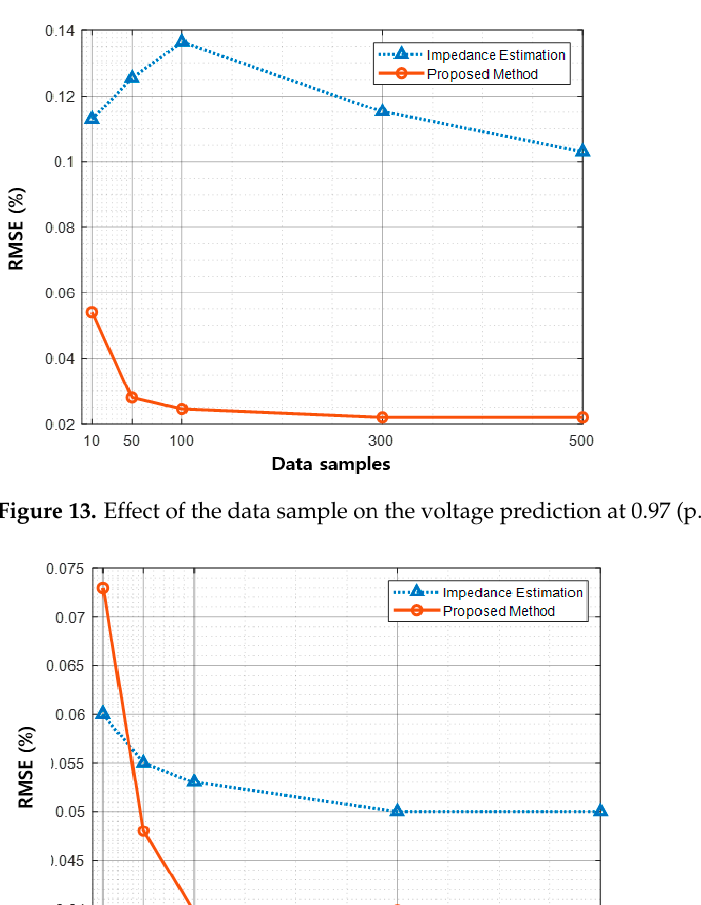
Figure 13. Effect of the data sample on the voltage prediction at 0.97 (p.u) slack node voltage.